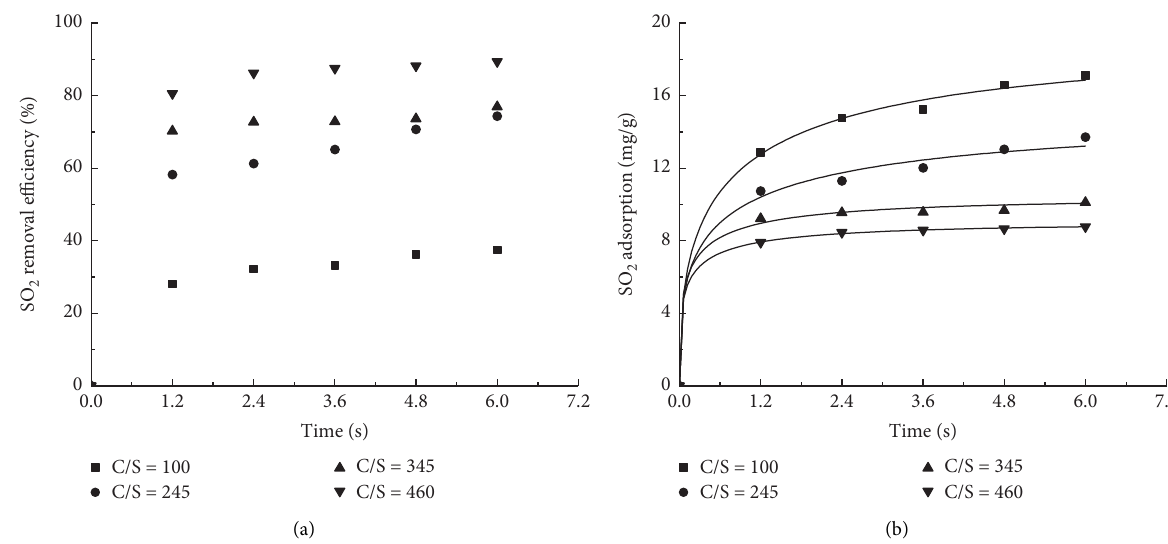
Figure 5: Influence of AC/S molar ratio on (a) SO concentration is 0.085%, 6%, and 8%.